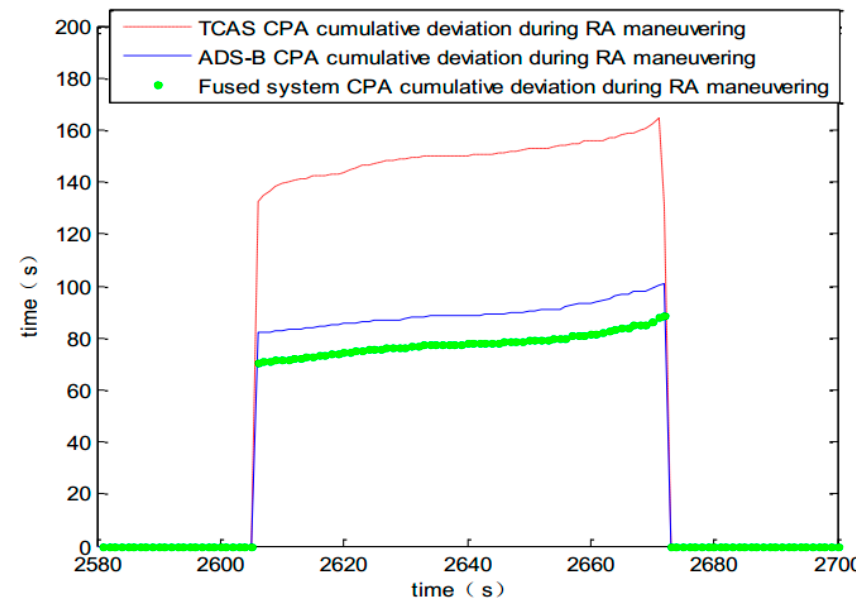
Figure 15. Accumulated deviation of CPA during the RA decision interval. Figure 14. Accumulated deviation of CPA during the RA decision interval. Sensors 2017 , 17 , 2611